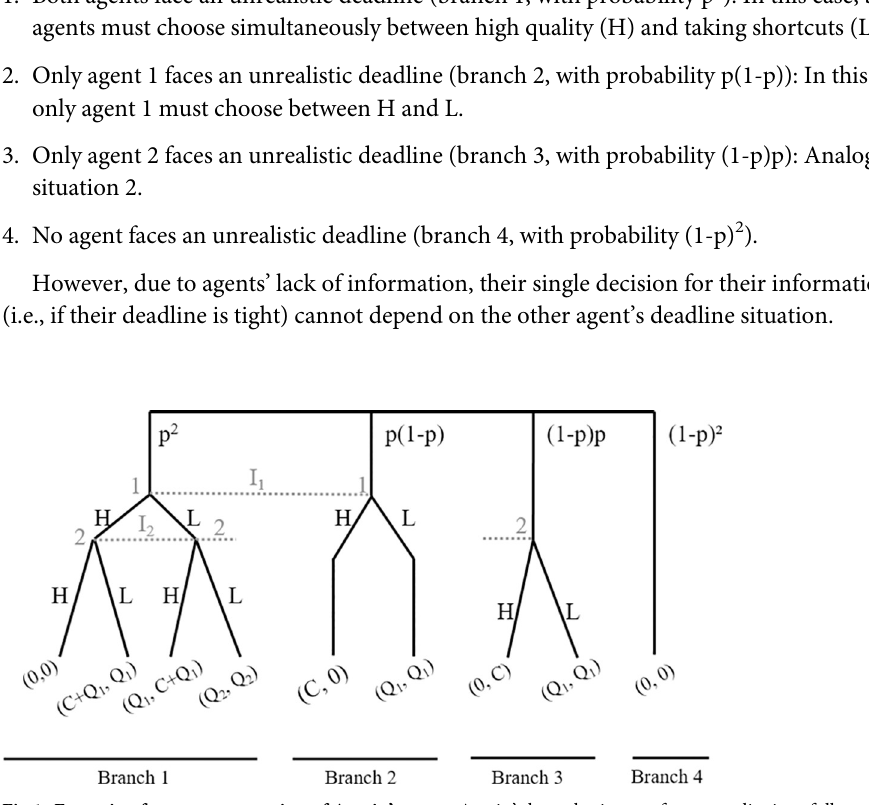
Fig 1. Extensive-form representation of Austin’s game. Austin’s hypothesis on software quality is as follows. Agents will play according to the unique NEQ (L, L) for p < p crit . For p � p crit , agents will play the payoff-dominant NEQ (H, H). Thus, conditional on having an unrealistic deadline, for low p all decisions will be L and for high p all decisions will be H, that is, the percentage of H-decisions increases in